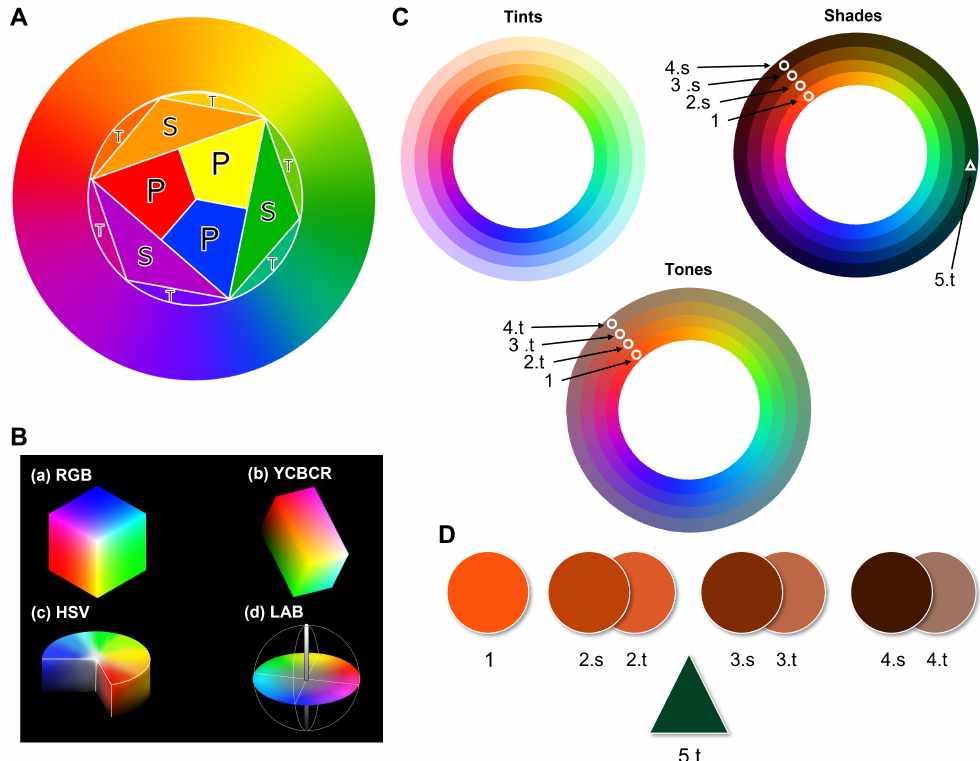
Figure 1. Color theory bases: ( A ) representation of color wheel; the color wheel is obtained from the primary colors (P) Red, Yellow, and Blue; by blending the primary colors, we get the secondary (S) colors, Green, Purple, and Orange; finally, by blending the secondary colors, we obtain the tertiary (T) colors, Yellow-Green, Blue-Green, Blue-Violet, and Red-Violet; ( B ) depiction of the concept of tints, shades, and tones with the color wheel in A; in every wheel, each ring going outward shows a 25% increase in added white for tints, black for shades, and gray for tones; these show the near-achromatic colors. ( C ) the four main color spaces used in digital imaging—RGB, YCbCr, HSV, and CIELAB; ( D ) color picker results displaying the colors within the shapes marked in the shades (s)- and tones (t)-modified color wheels; the circles show the effect of adding black (shades) or gray (tones) to orange; the triangle shows a dark shade of green called forest green; the obtained results show that what we understand as brown is not a pure color but rather shades of pure colors ranging from red to warm